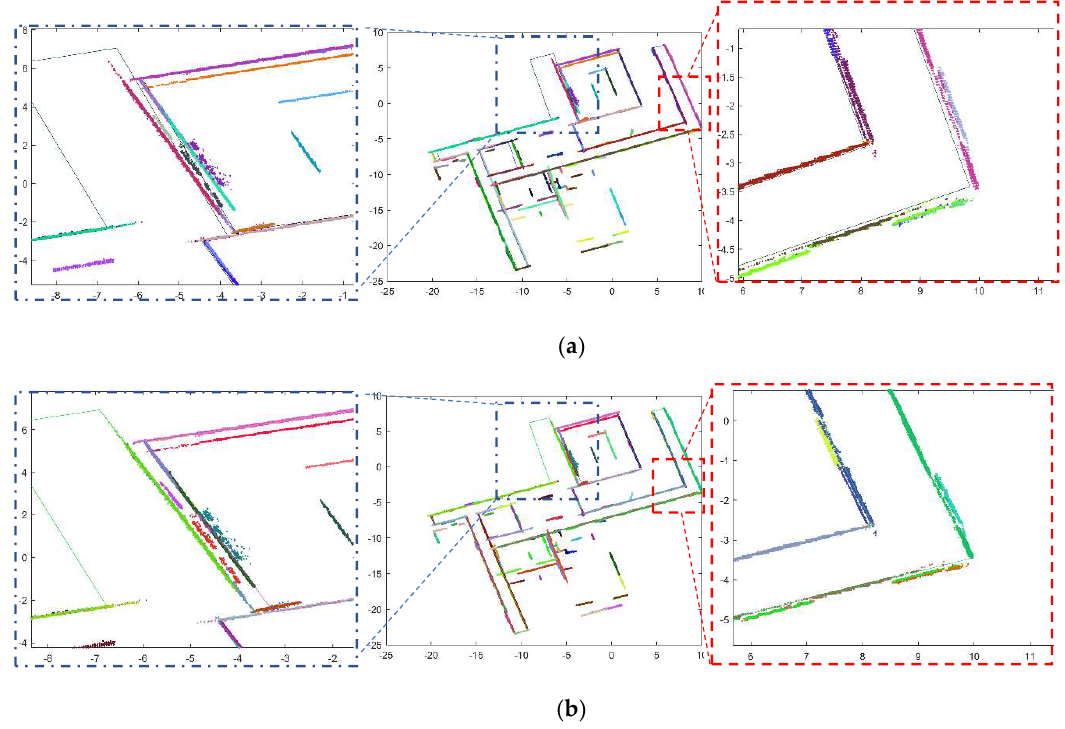
Figure 6. Adjustment of wall segments using points of vertical planes: ( a ) Before adjustment; and ( b ) after adjustment.